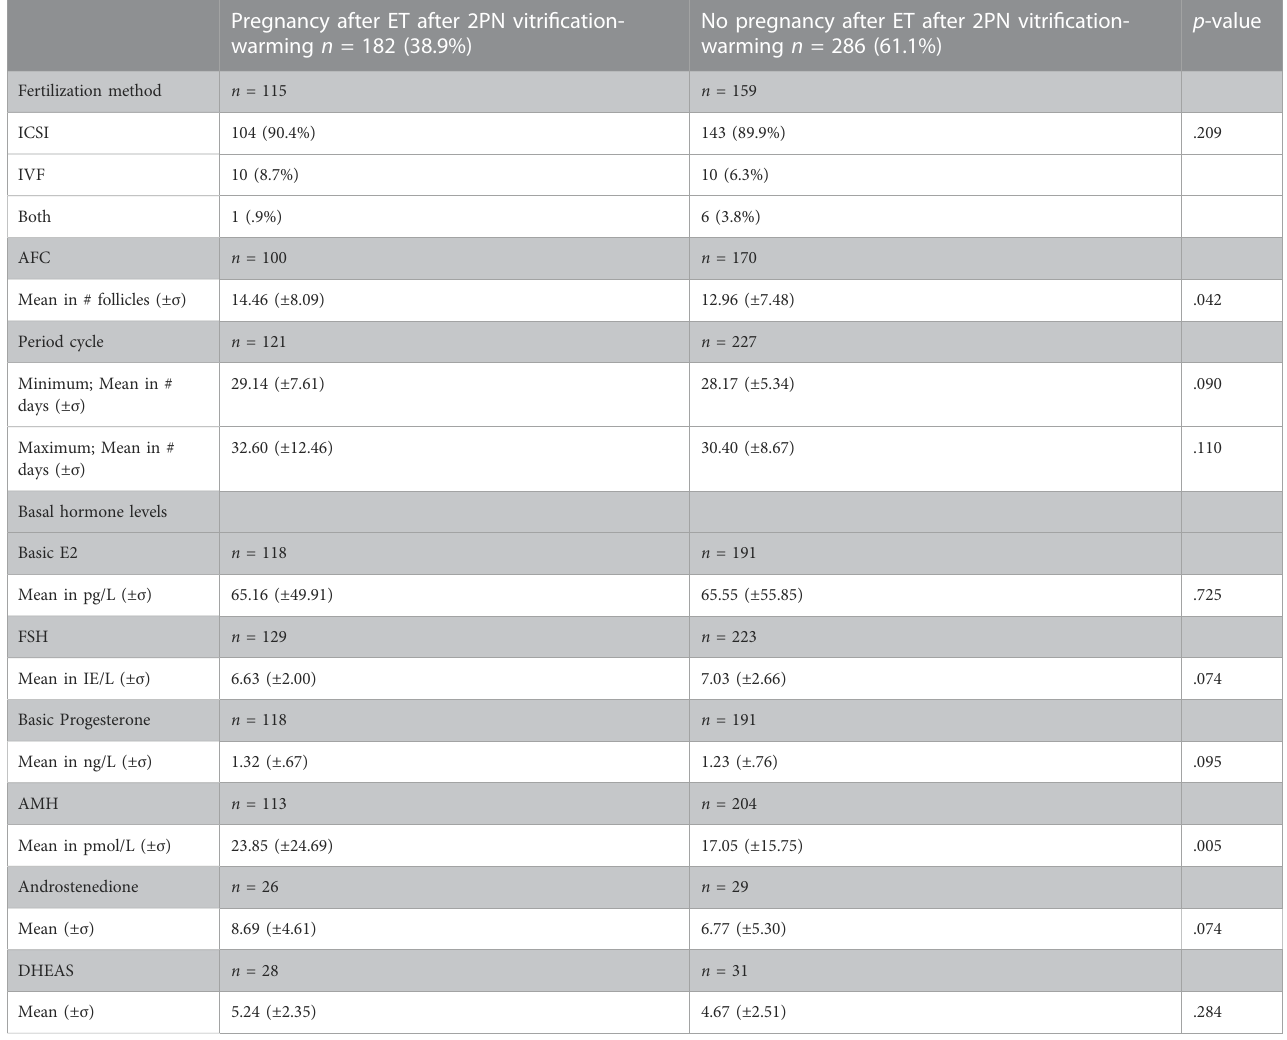
TABLE 3 Overview of basic conditions for fertility treatment. Pregnancy after ET after 2PN vitri fi